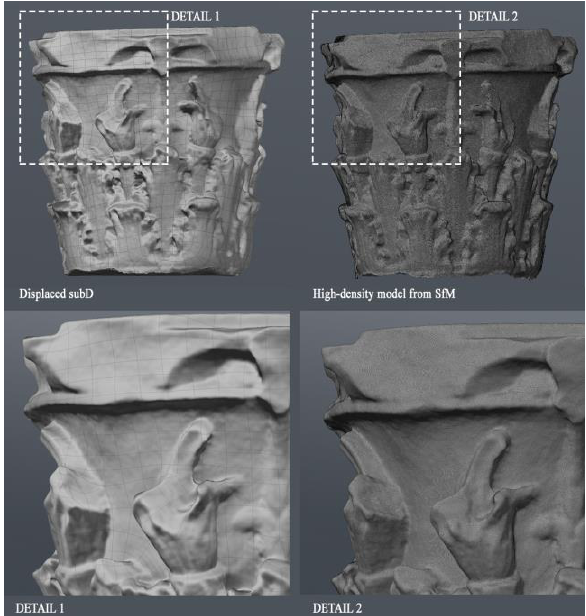
Figure 3. Left: the capital converted into displaced subD, right the original high-poly mesh. Optimized pure-quad meshes also enable fast and enhanced parameterization, rather than dense triangular meshes.